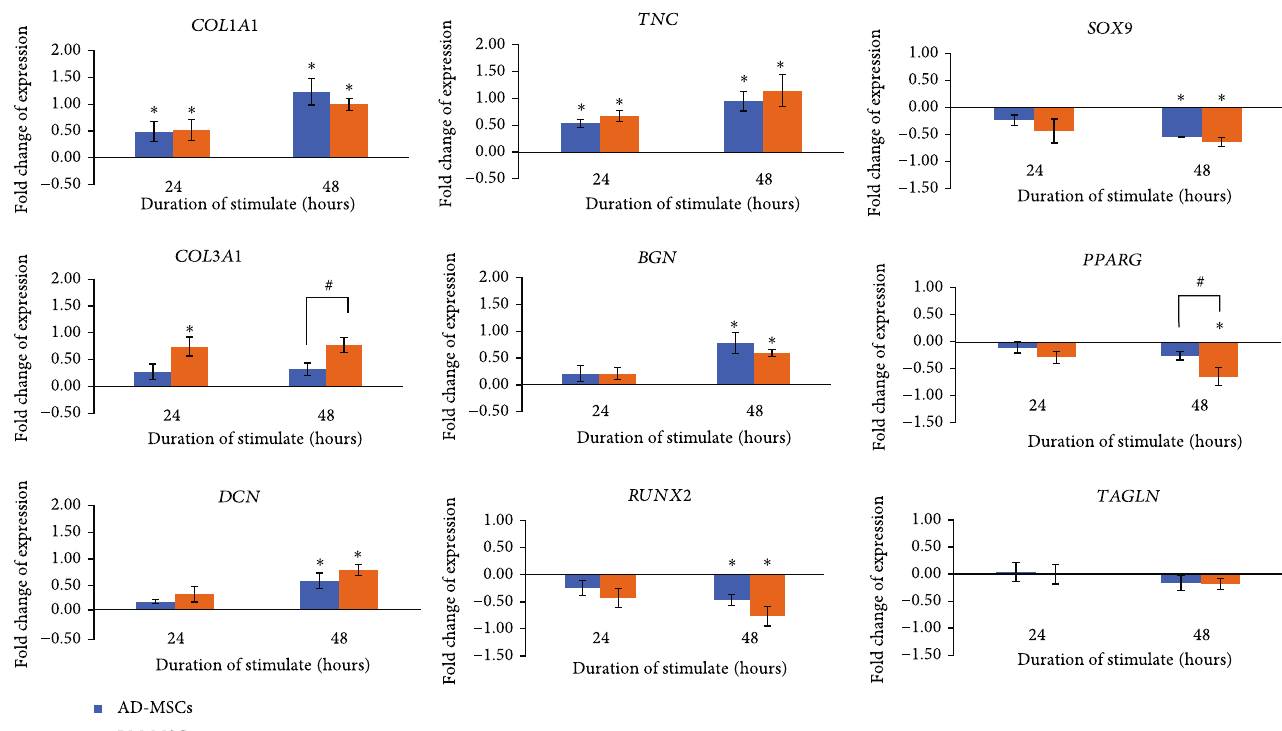
Figure 7: mRNA expression level of di ff erent genes in AD-MSCs and BM-MSCs subjected stretching at 24h and 48 h. The expression level of each gene was normalised with the level of average housekeeping genes. The value of fold change was presented as ratio of strained group to the unstrained group. Statistical signi fi cance ( p < 0 : 05 ) was represented by an asterisk ( ∗ ) in comparison to the unstrained cells represented by the Y axis (indicated as 0.00). Statistical signi fi cance ( p < 0 : 05 ) was also represented by a hash (#) which is a comparison between AD-MSCs and BM-MSCs. N = 4 , n = 3 . Error bar = ±SD